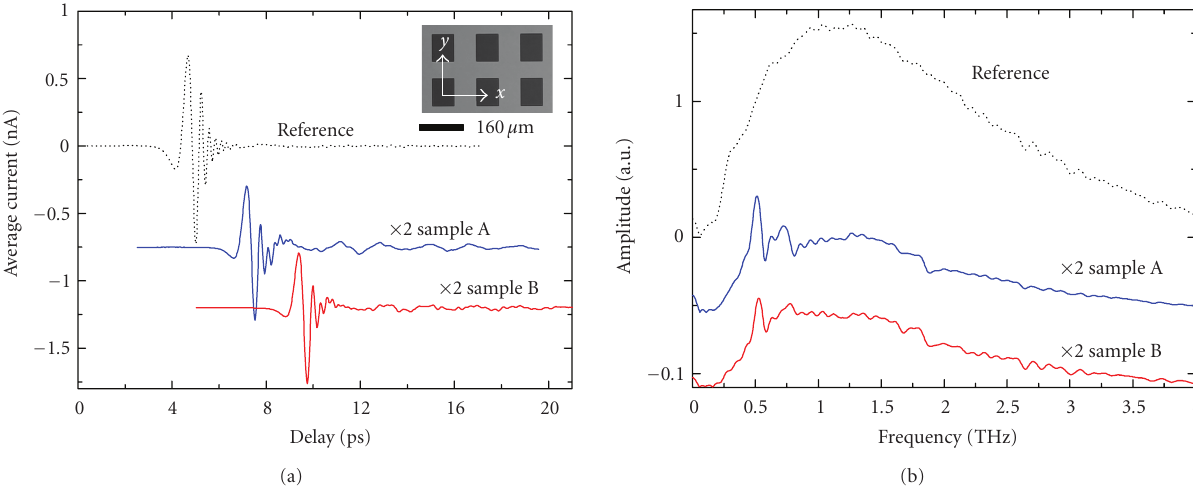
Figure 1: (a) THz-TDS measured transmitted terahertz pulses and (b) the corresponding spectra through the reference and array samples (multiplied by two). The curves in both (a) and (b) are displaced vertically for clarity. Inset: microscopic image of the array.